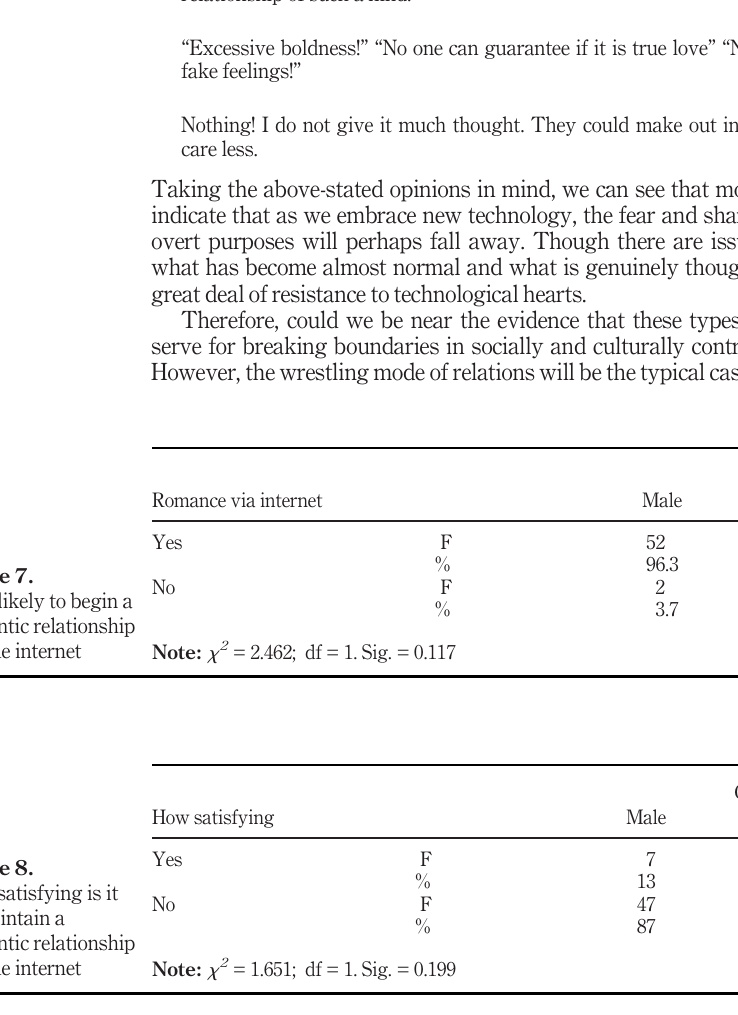
Table 8. How satisfying is it to maintain a romantic relationship via the internet